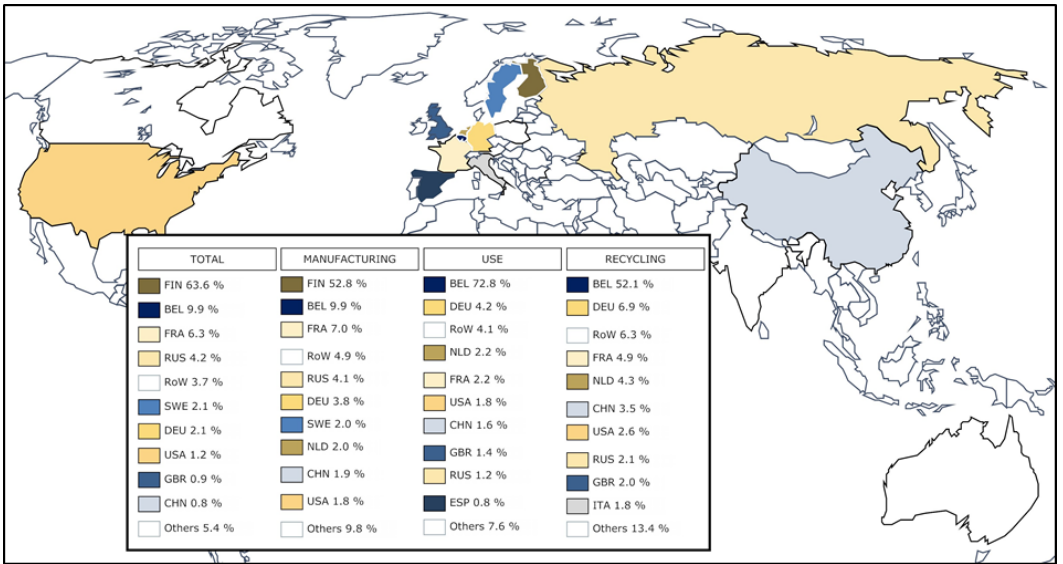
Figure 9. Geographical resolution and country contribution to the economic impact measured in production of goods and services in €.